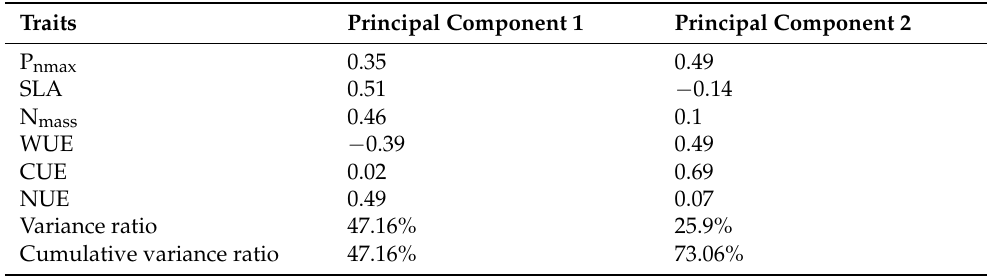
principal components